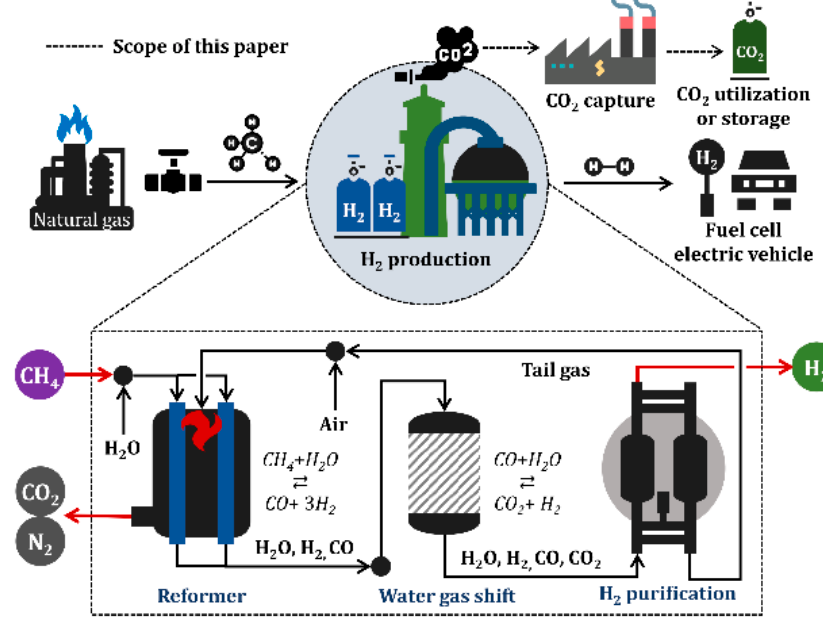
Figure 1. Schematic of industrial hydrogen production using steam methane reforming.